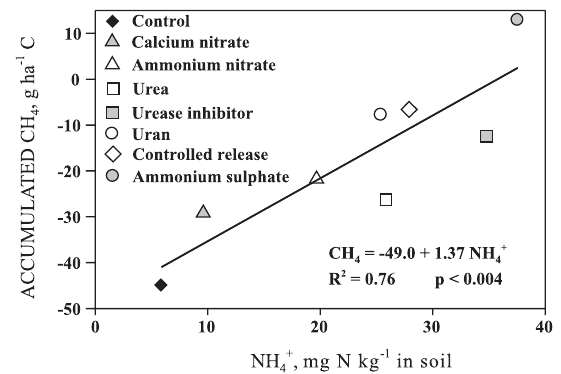
Figure 4. Relationship between accumulated flux of CH (g ha -1 C) and mean contents of ammonium 4 (mg N kg -1 ) in the soil for the 15 day period after application of the nitrogen fertilizers to a Gleysol in the South of